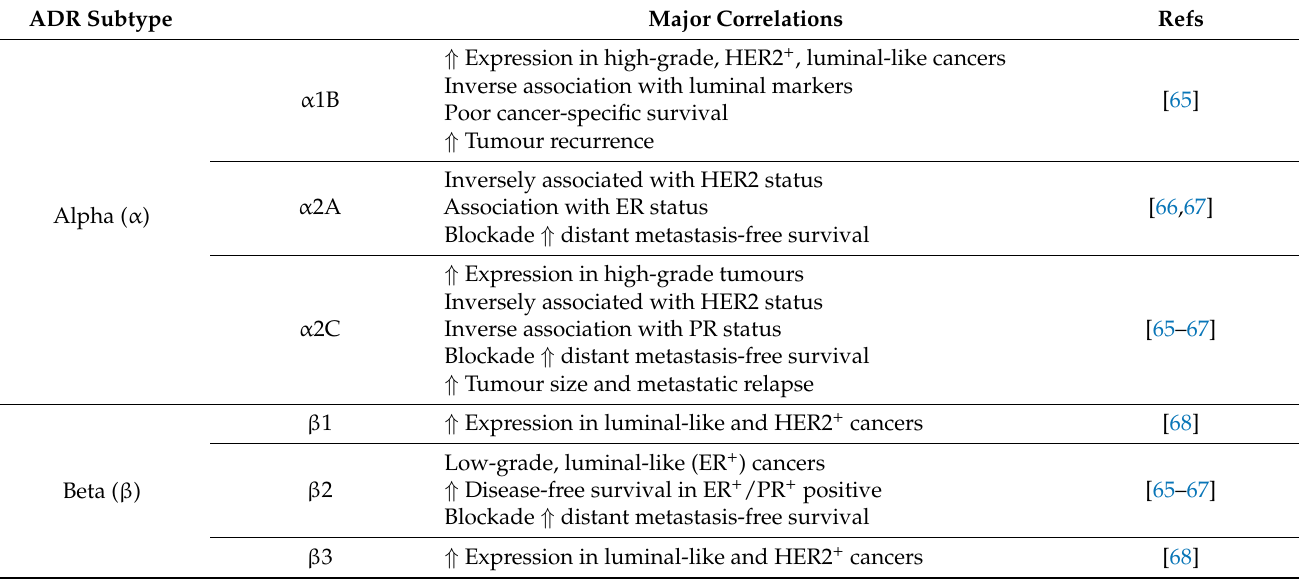
Table 1. A summary of the expression of ADRs in BRCA and associated